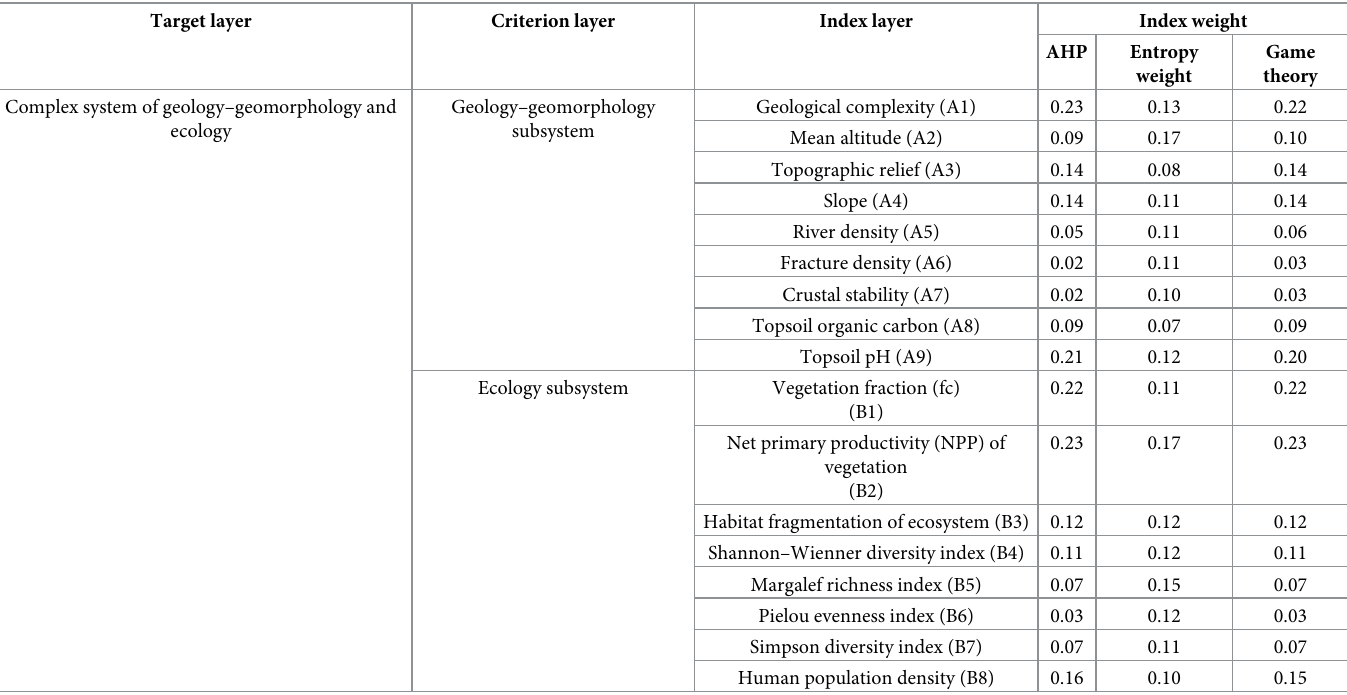
Table 3. Results of index system weighting of geology–geomorphology and ecology in Northeast China. Target layer